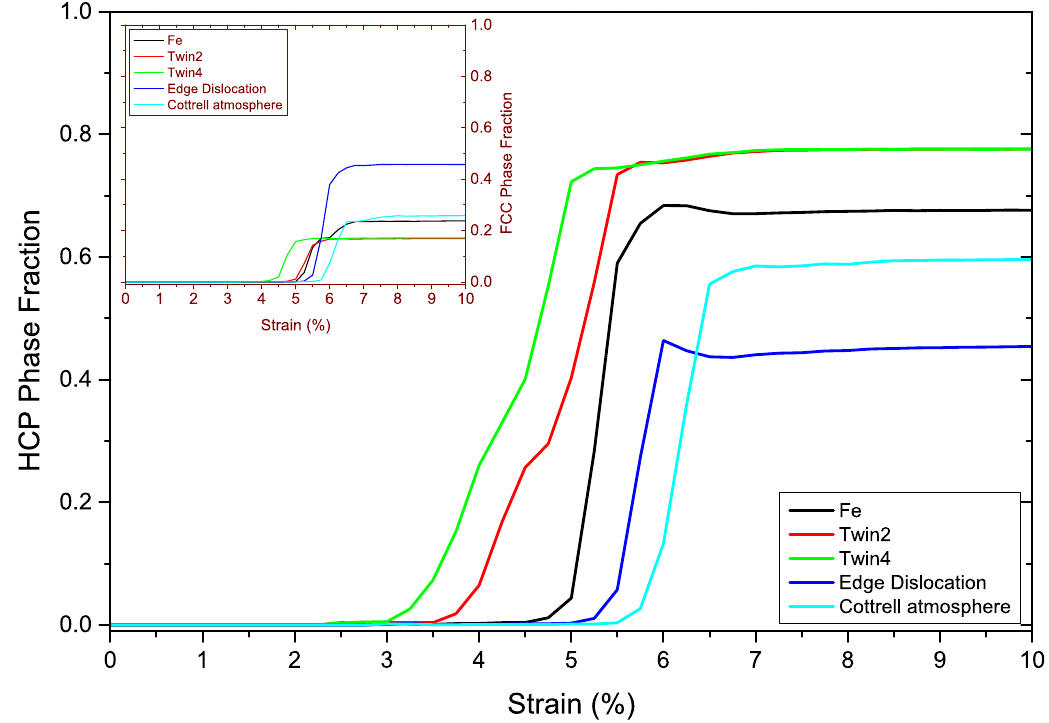
Figure 13. Hexagonal close-packed phase fraction versus strain for simulations of the sample with two twin surfaces (red), four twin surfaces (green), edge dislocations (blue) and Cottrell atmosphere (cyan) and pure iron single-crystals (black). Fcc fractions for all five simulations are embedded in the top left